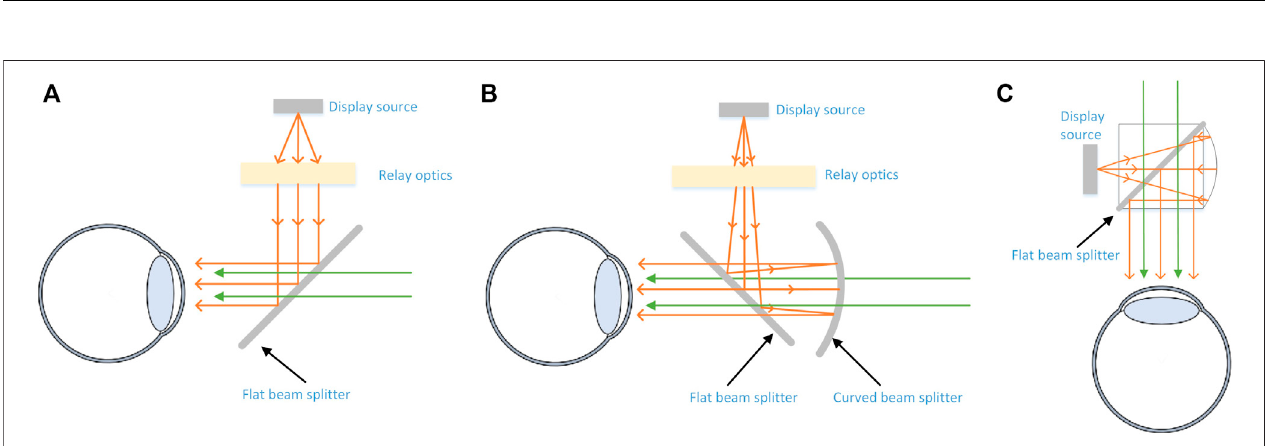
FIGURE8| SchematicdiagramofbeamsplitterbasedARNEDs. (A) showsa fl atBSbasedARNED; (B) and (C) showtwobirdbathdesignsforARNEDs(Onlythe central FOV of the NEDs is shown in the